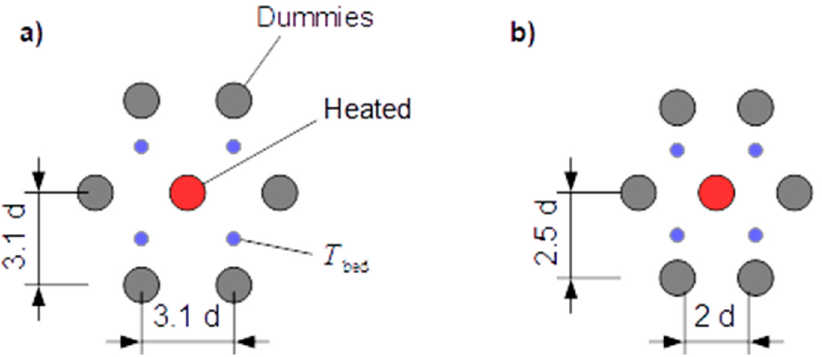
Figure 7. Investigated tube spacings: ( a ) Wide and Regular; ( b ) Narrower horizontal spacing, called sandTES tube spacing. Local bed temperature measurements were made at T bed